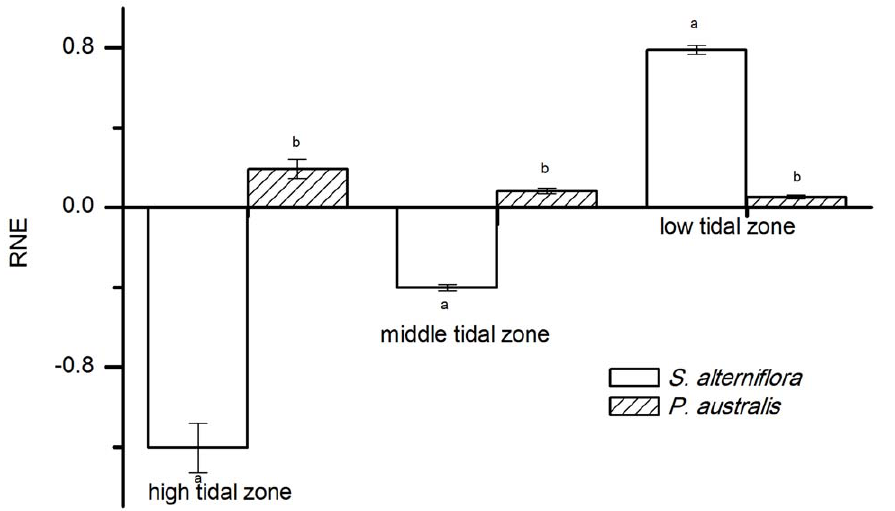
Figure 3. The relative neighbor effect (RNE) of P.australis and S.alterniflora in different tidal zones. The performance of target plants was measured by the relative growth rate per day (RGR). Different letters indicate significant